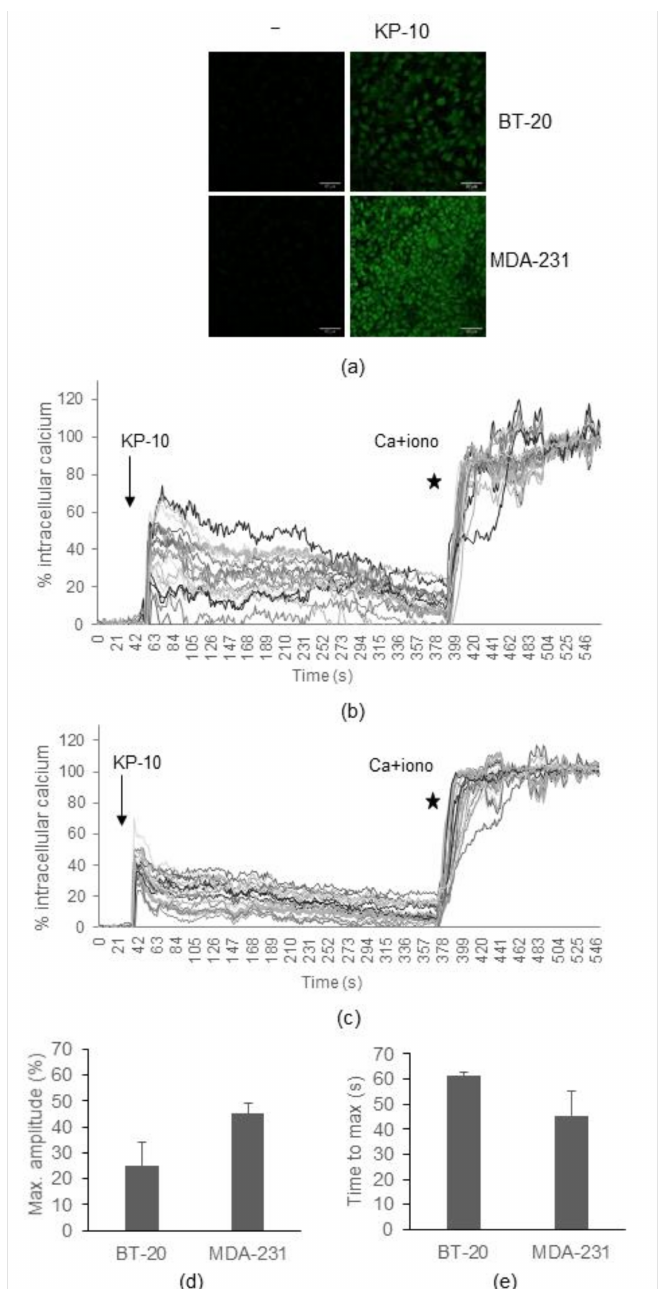
Figure 2. KP-10 induces similar levels of calcium mobilization in BT-20 and MDA-MB-231 cells. BT-20 and MDA-MB-231 cells were loaded with the calcium indicator dye, Fluo-3 AM, imaged using a Zeiss LSM800 at 20 × magnification every 1.5 s before 100 nM KP-10 was added. After at least 300 s, 1 µ M Ionomycin + 1 M CaCl 2 was added (positive control) to determine the maximal Fluo-3 excitation. ( a ) Fluorescence images of BT-20 and MDA-MB-231 cells before (-) and after KP-10 stimulation. ( b ) A representative experiment showing 20 BT-20 cells tracked for fluorescence intensity before and after KP-10 stimulation (arrow) and Ionomycin stimulation (star). ( c ) A representative experiment showing 20 MDA-MB-231 cells tracked for fluorescence intensity before and after KP-10 stimulation (arrow) and Ionomycin stimulation (star). ( d ) Quantification (mean ± SEM) of the maximum amplitude reached after KP-10 stimulation in BT-20 and MDA-MB-231 cells ( e ) Quantification (mean ± SEM) of the time taken to reach maximum mobilization after KP-10 stimulation in BT-20 and MDA-MB-231 cells. There was no significant difference ( p > 0.05) in maximum amplitude or time to maximum amplitude between the two cell